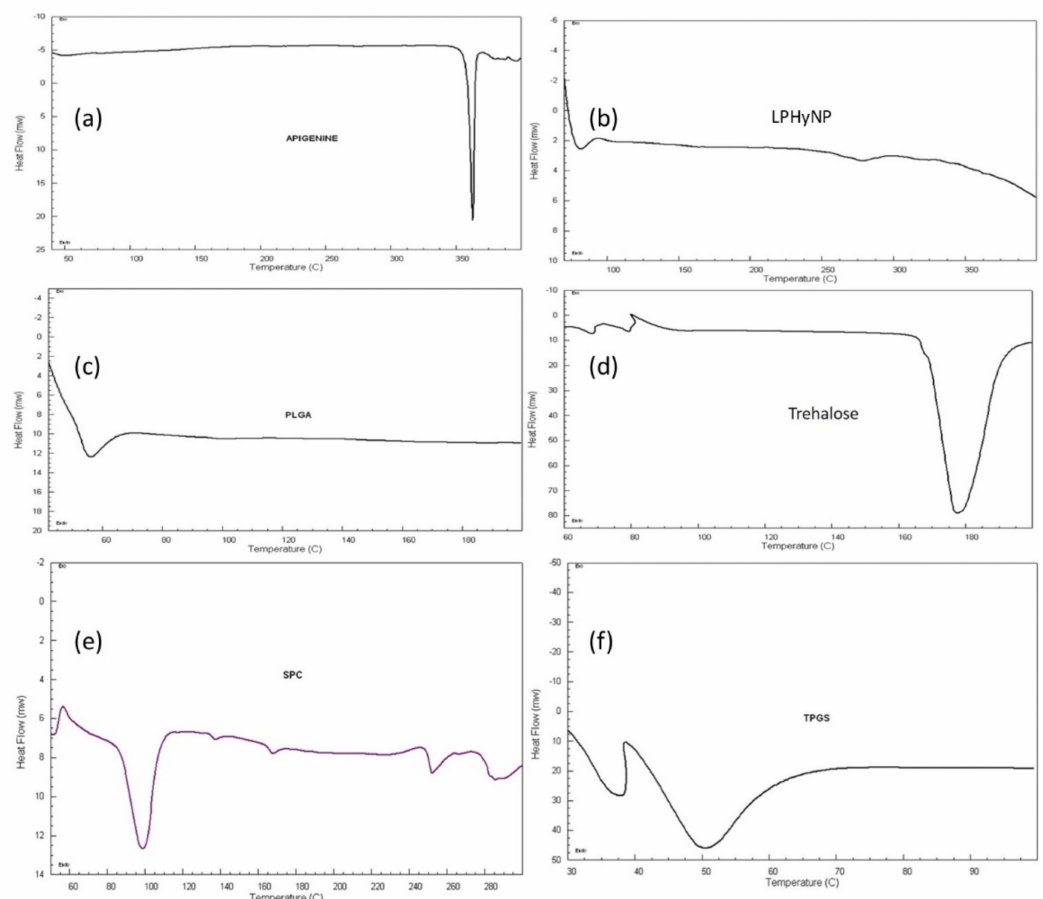
Figure 2. DSC thermogram of ( a ) AGN, ( b ) LPHyNP, ( c ) PLGA, ( d ) trehalose, ( e ) SPC-3, and ( f )